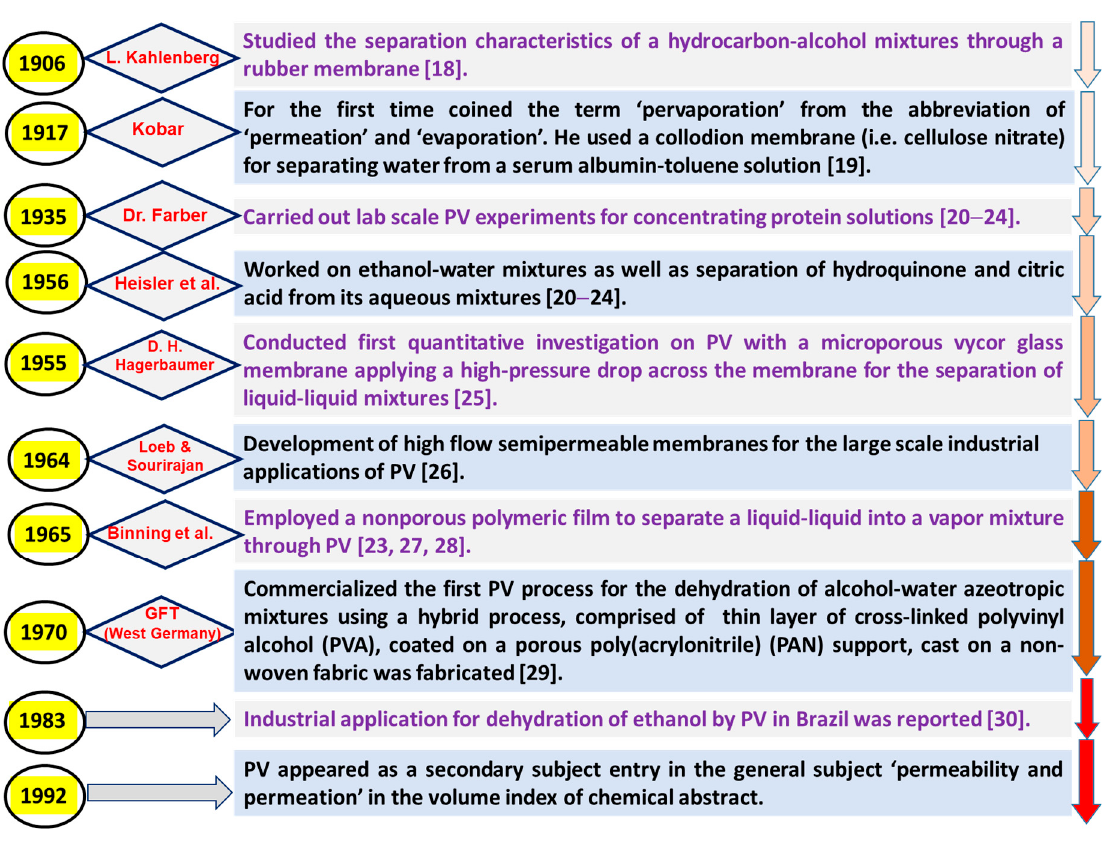
Scheme 1. Tree diagram for showing the historical development of pervaporation